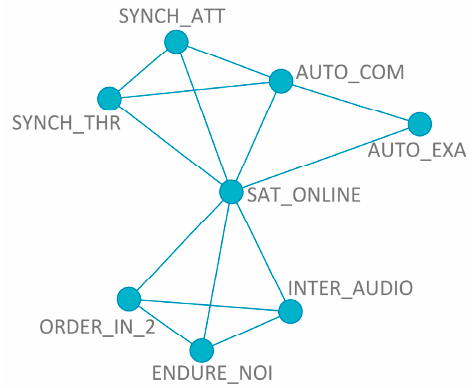
Figure 6. Inferred mRMRe network topology of the selected variables for the model of students’ satisfaction with the online learning method.